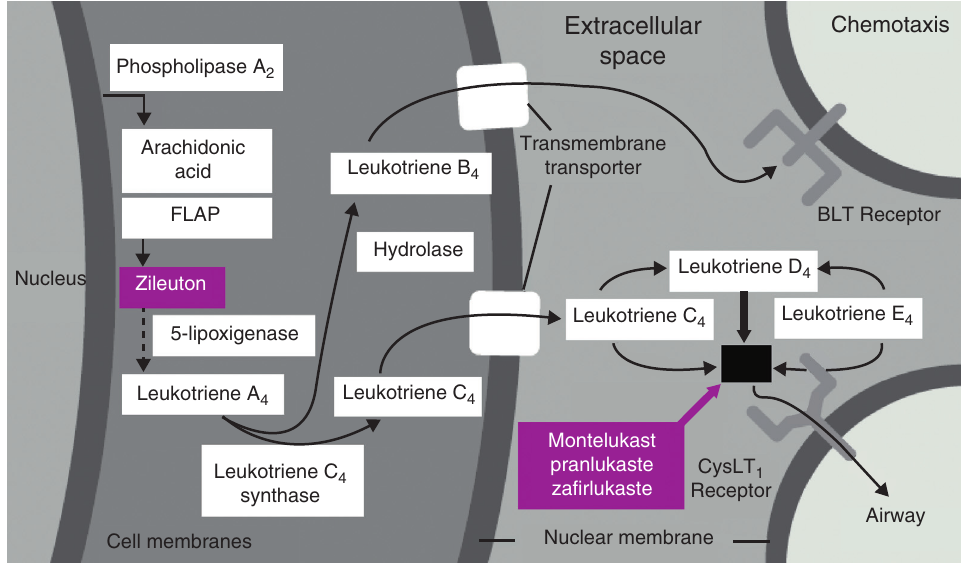
Eicosanoid pathway leading to leukotriene formation.